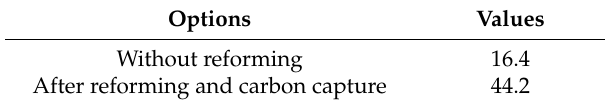
Table 6. Heating value of syngas with and without pre-combustion capture (Unit: MJ/kg).